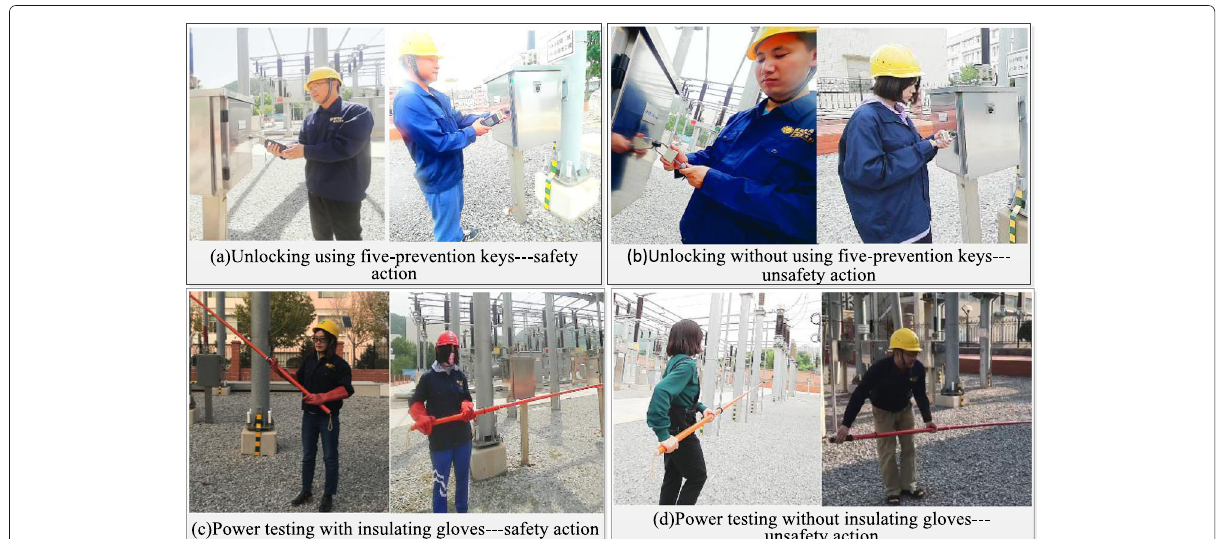
Fig. 10 Safe and unsafe actions